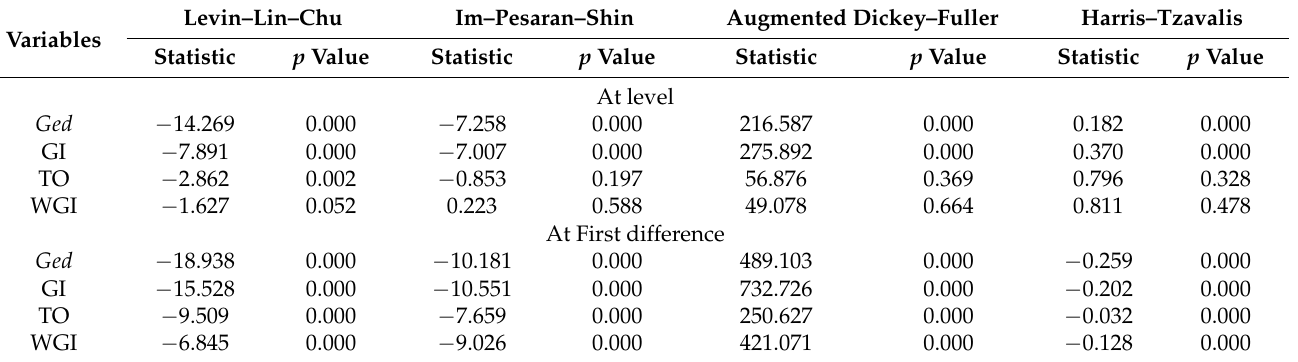
Table 3. The finding of stationarity of the selected variables.